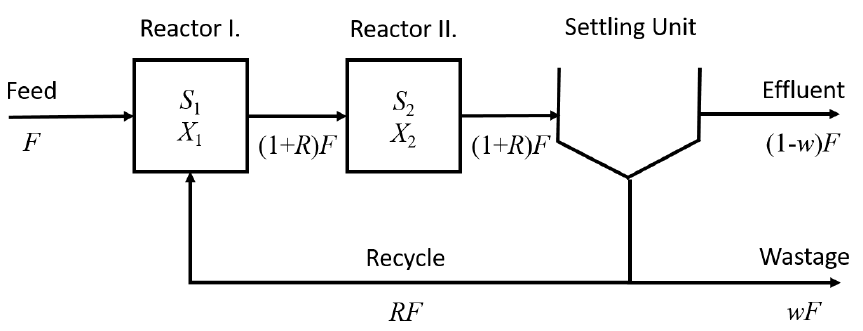
Figure 3. Block diagram of the standard reactor cascade (SRC) of the wastewater treatment process. The figure contains the names of the flows above the arrows and the flowrates below the arrows. F refers to the flowrate, R denotes the recycle ratio, S i and X i represent the concentrations of the substrate and microorganisms ( i stands for the number of the reactors), and w is the waste